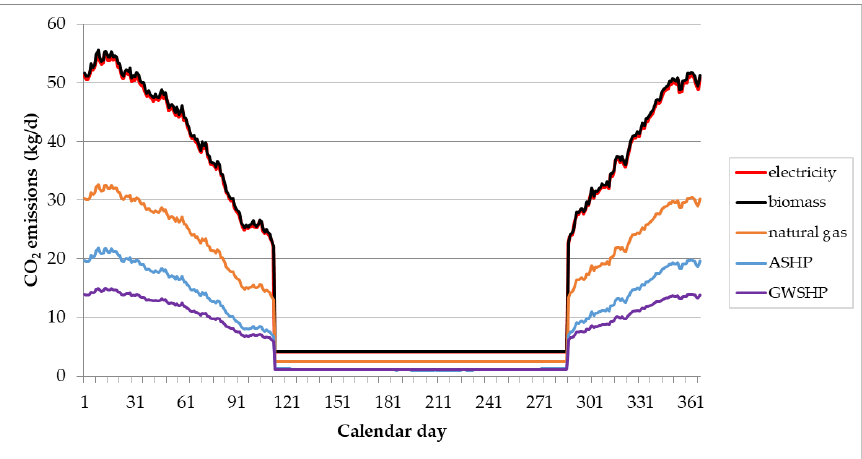
Figure 5. Daily CO 2 emissions of different heating solutions in the case of a theoretical house with a heat demand of 90.00 GJ/y. Table 2. CO 2 emissions of electric heating and combustion in kg/y in the case of a theoretical house with a heat demand of 90.00 GJ/y.